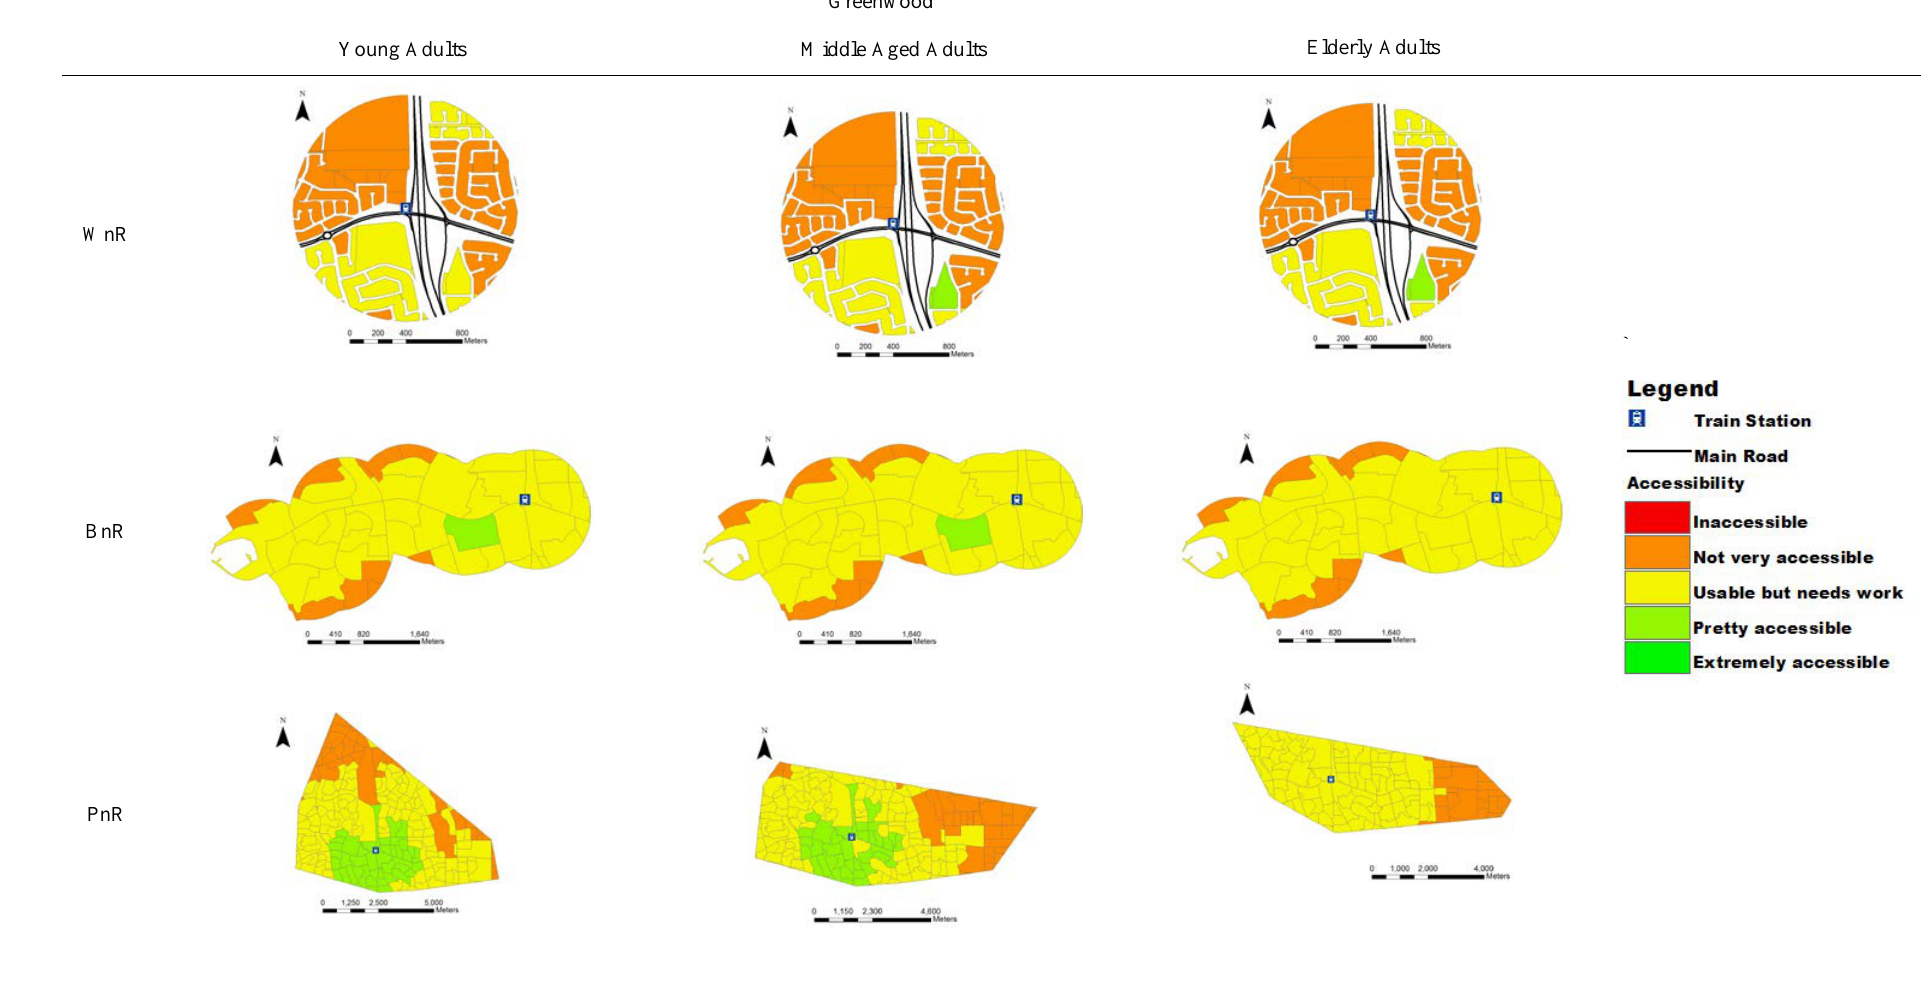
Figure 6. Map of measured accessibility for the different travel modes and age